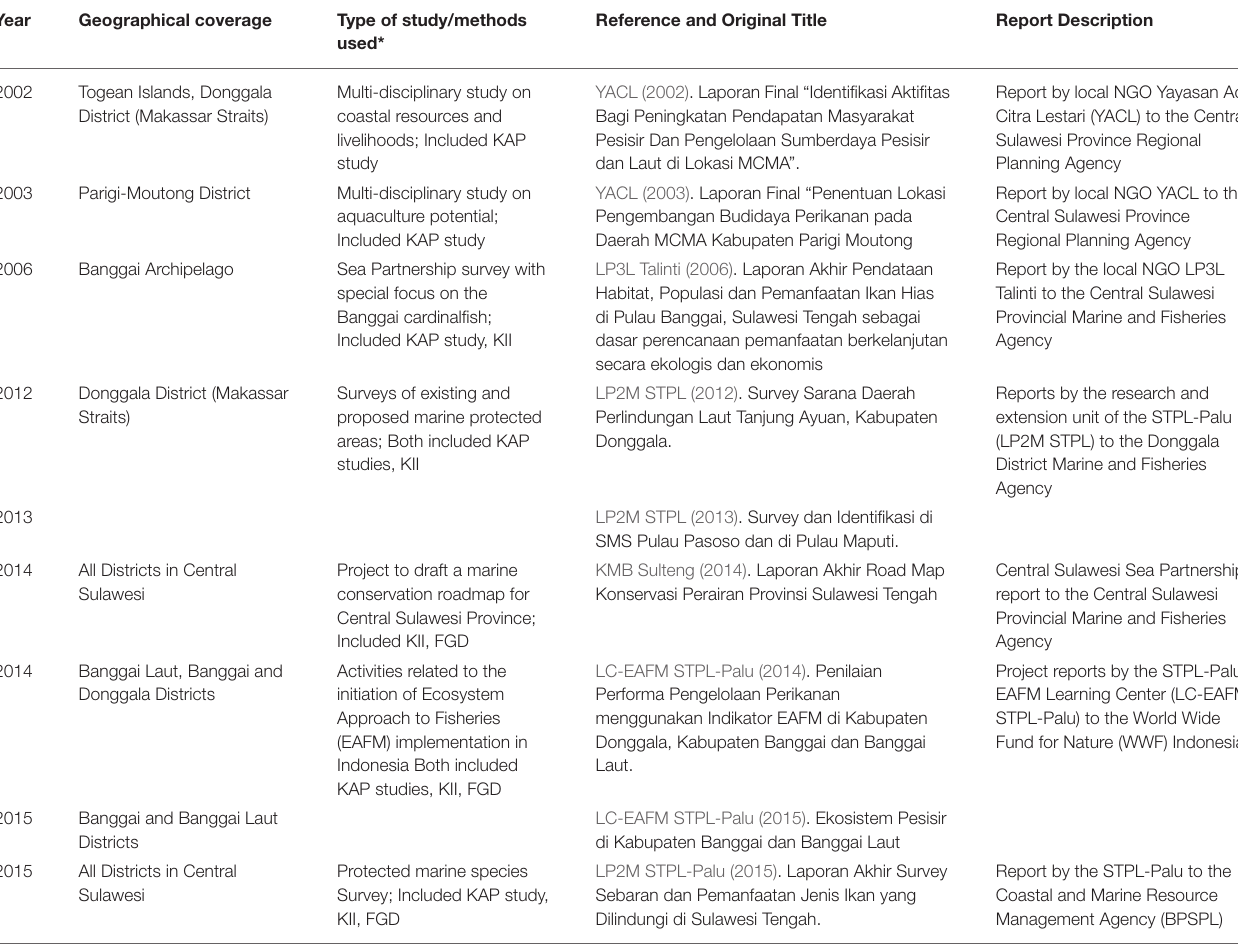
TABLE 1 | Main “gray literature” sources of data on dugongs in Central